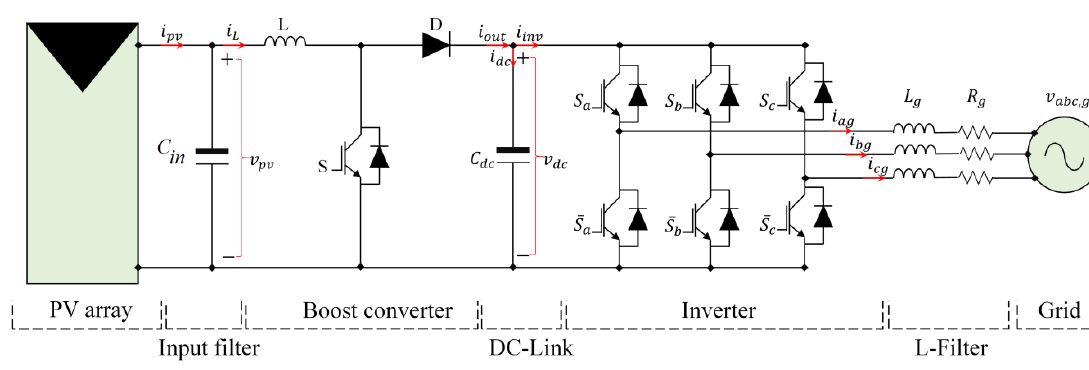
Figure 1. Two-stage grid-tied PV system topology.